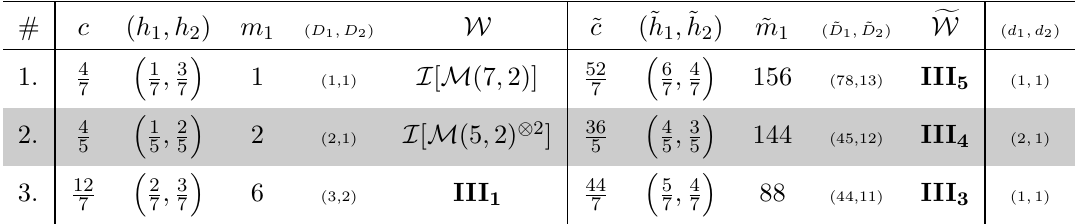
Table 4. IVOA-type pairings, c H = 8 with ( n 1 , n 2 ) = (1 , 1) .